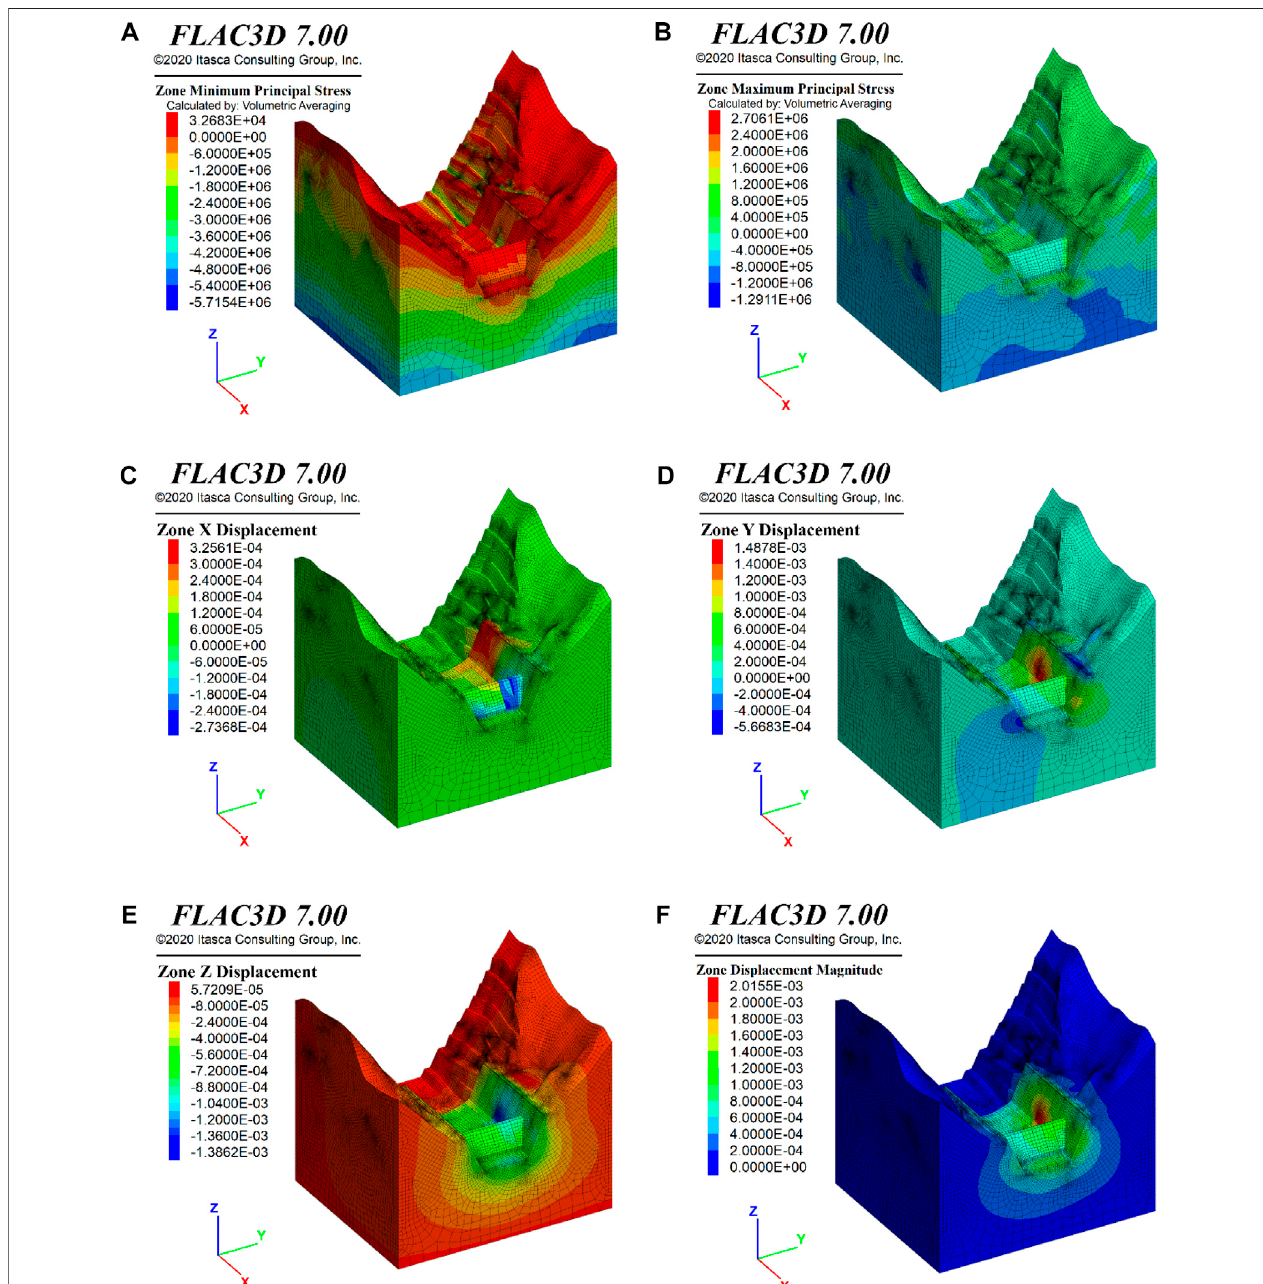
FIGURE 3 | Numerical modelling results of the whole model for working condition of the frequent fl ood: (A) Major principal stress, (B) Minor principal stress, (C) Displacement along the river, (D) Displacement transverse the river, (E) Vertical displacement, (F) Resultant displacement.